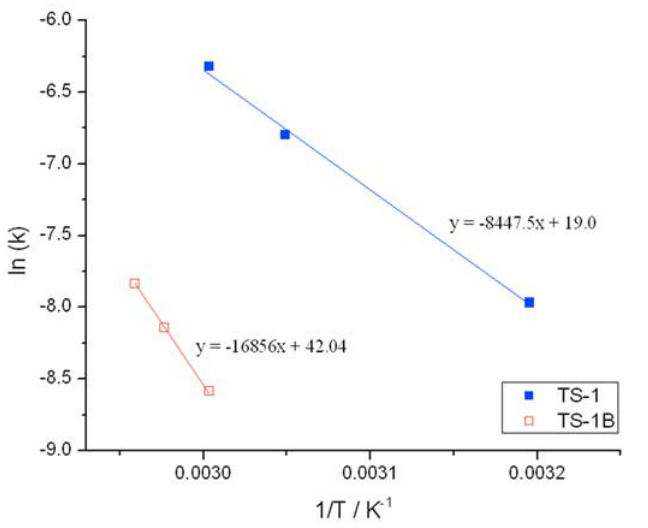
Figure 6. Arrhenius expression for H 2 O 2 decomposition over (blue squares) TS-1 and (hollow red squares) TS-1B. Reaction conditions: [H 2 O 2 ] = 0.25 M, mass of catalyst = 50 mg, various